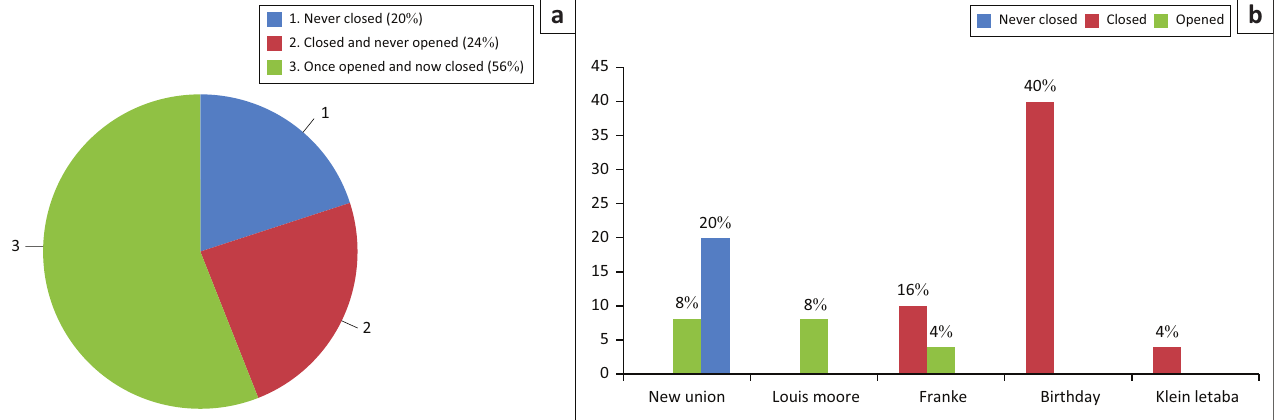
FIGURE 4: (a) The impact of artisanal mining on the rehabilitation efforts of abandoned mine shafts and (b) state of mine shafts in the five abandoned mines in the Sutherland